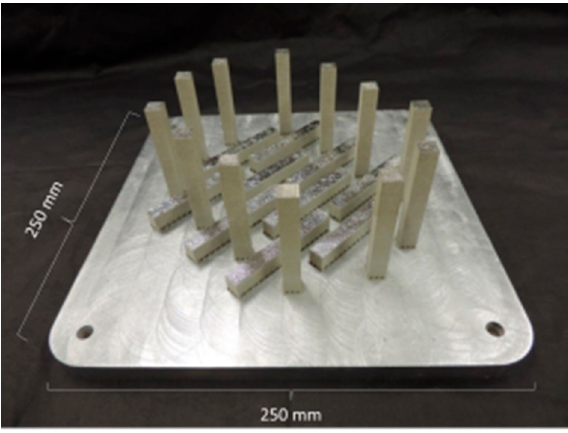
Figure 2. Geometry of SLM processed bars.